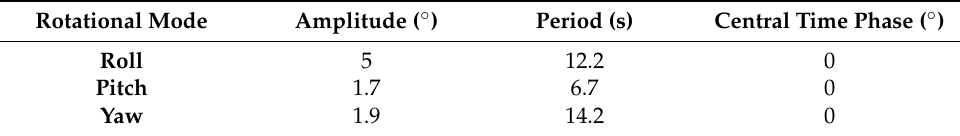
Table 2. The parameters of rotational